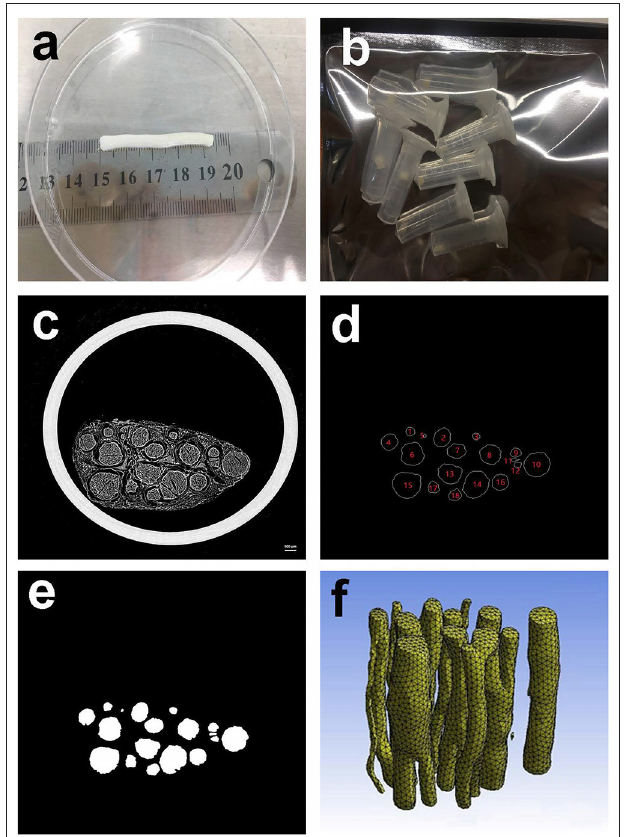
FIGURE 2 | Preparing materials. (a) Peripheral nerve; (b) Peripheral nerve specimens with a length of 3mm; (c) 10th MicroCT image of the second ∼ specimen; (d) Contours of the nerve bundle from 10th MicroCT image; (e) Binary image of the nerve bundles from the 10th MicroCT image; (f) 3D reconstruction result of the second specimen.